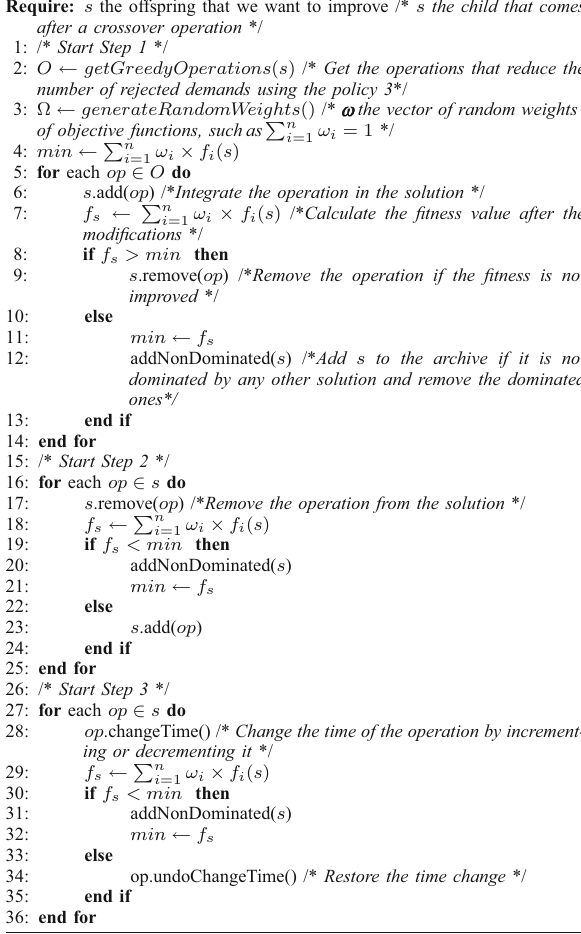
Algorithm 4 Local search procedure for the proposed memetic algorithm